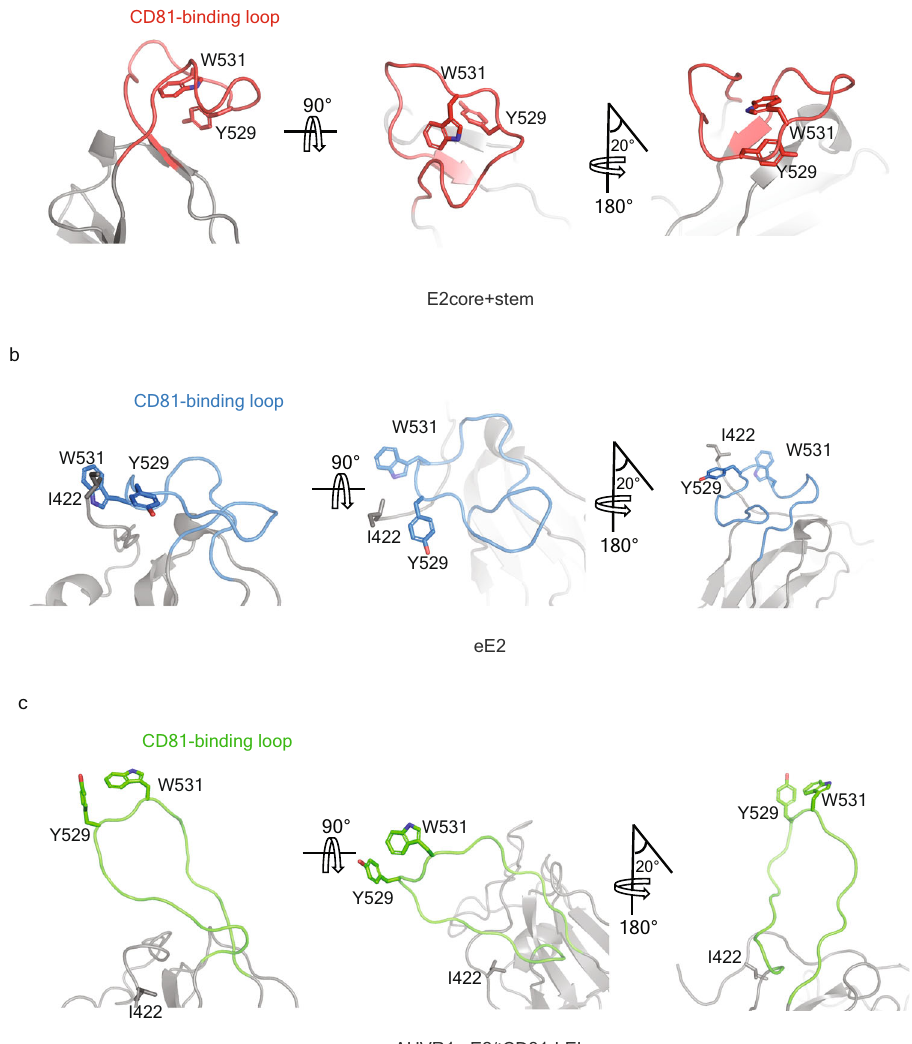
Fig.3|OrientationofCD81-bindingloopofE2.a Bent(E2core+stem,PDBID:8DK6), b retracted(eE2)(PDBID:7MWW),and c extended( Δ HVR1eE2)(PDBID:7MWX)in three different orientations. For clarity, Y529, W531, and I422 are highlighted and c bound tCD81-LEL is not shown.